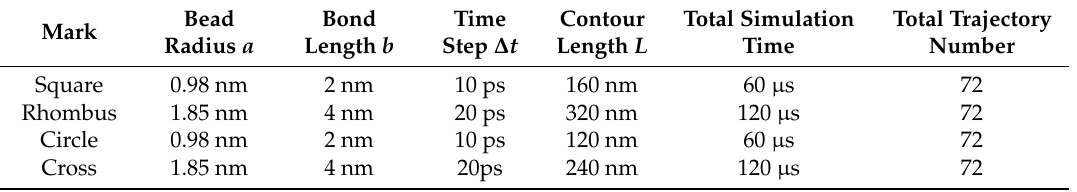
Table 2. Simulation parameters for the confinement of square tubes without stretching force.